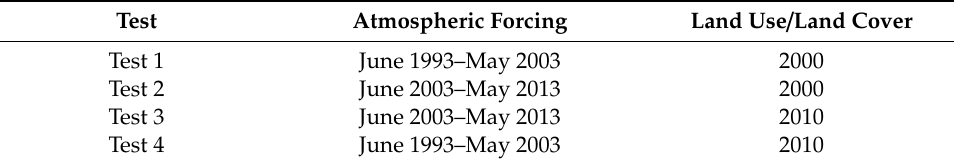
Table 1. The description of constructed simulation